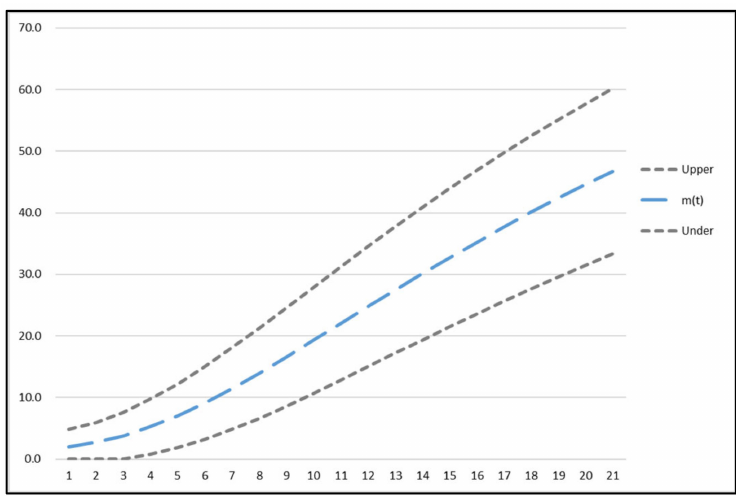
where z α is defined as the 100 ( 1 − α ) /2 percentile of the standard normal distribution [30].